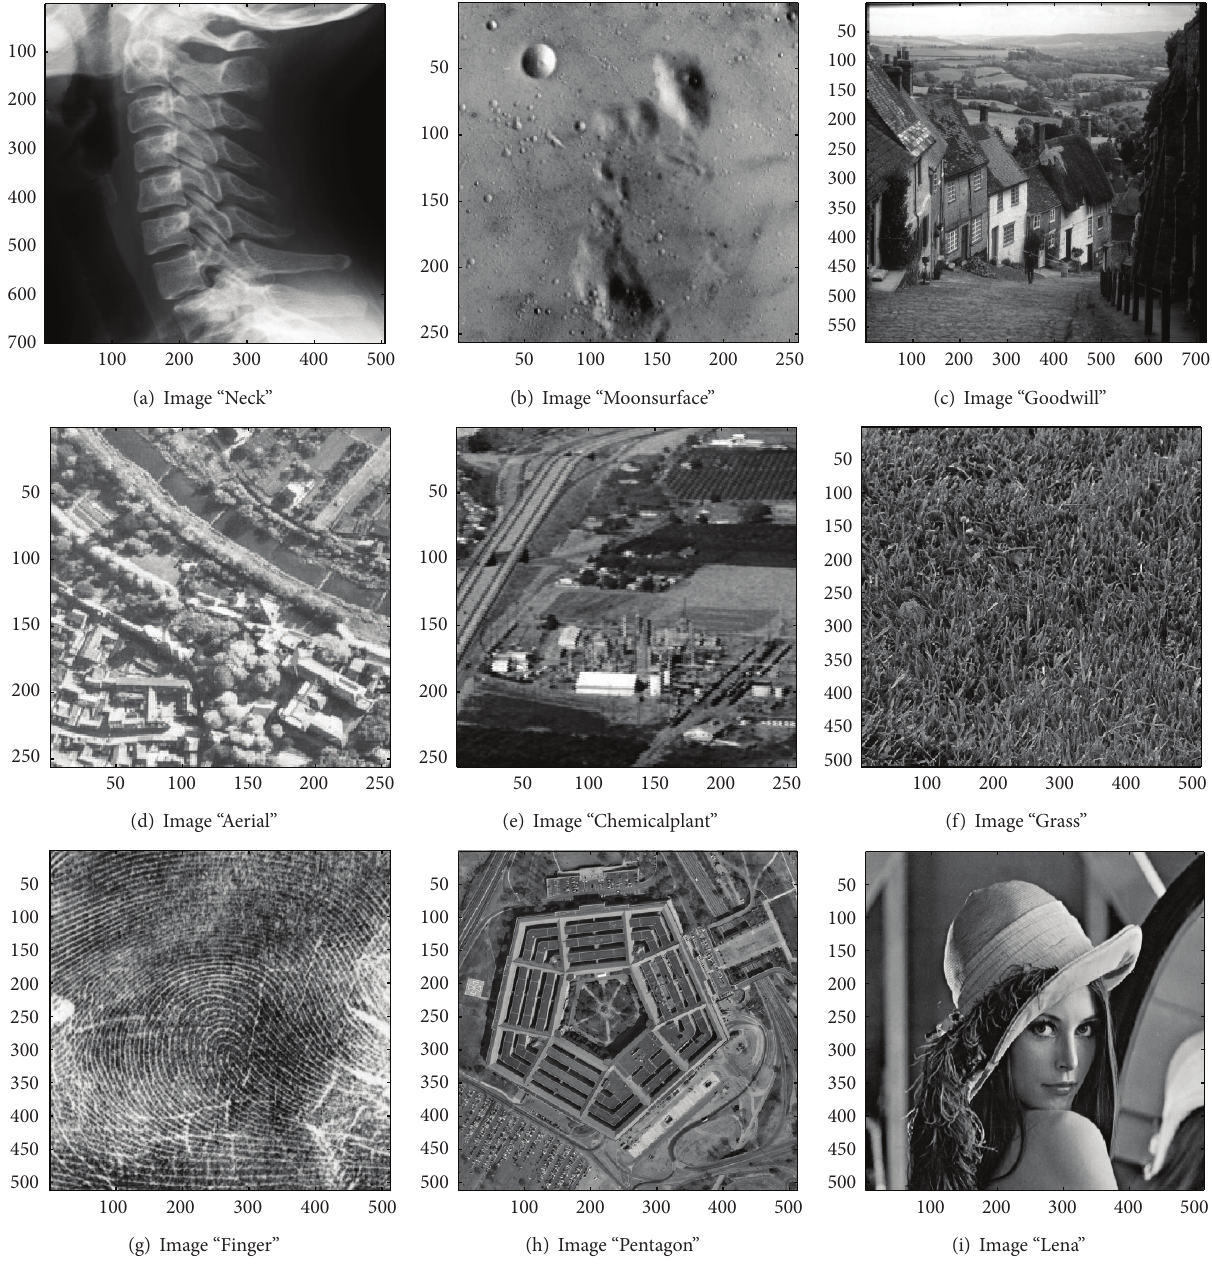
Figure 4: Test images in